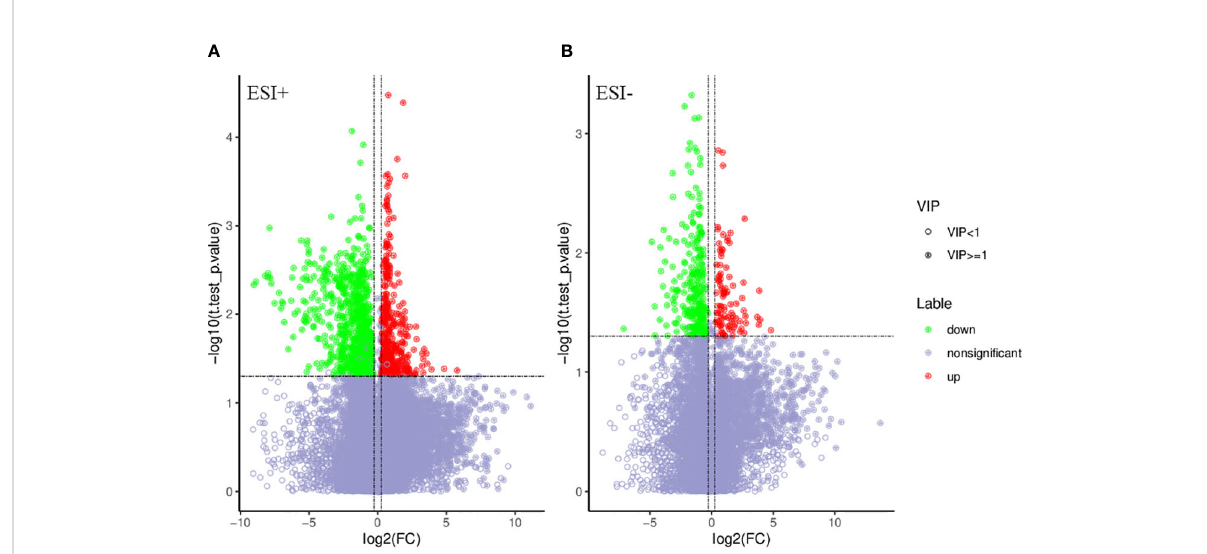
FIGURE 2 Volcano map of differential metabolites. Green is the down-regulated differential metabolite (labeled green), red is the up-regulated differential metabolite (labeled red), and metabolites without difference are labeled purple-gray. (A) positive ion mode, (B) negative ion